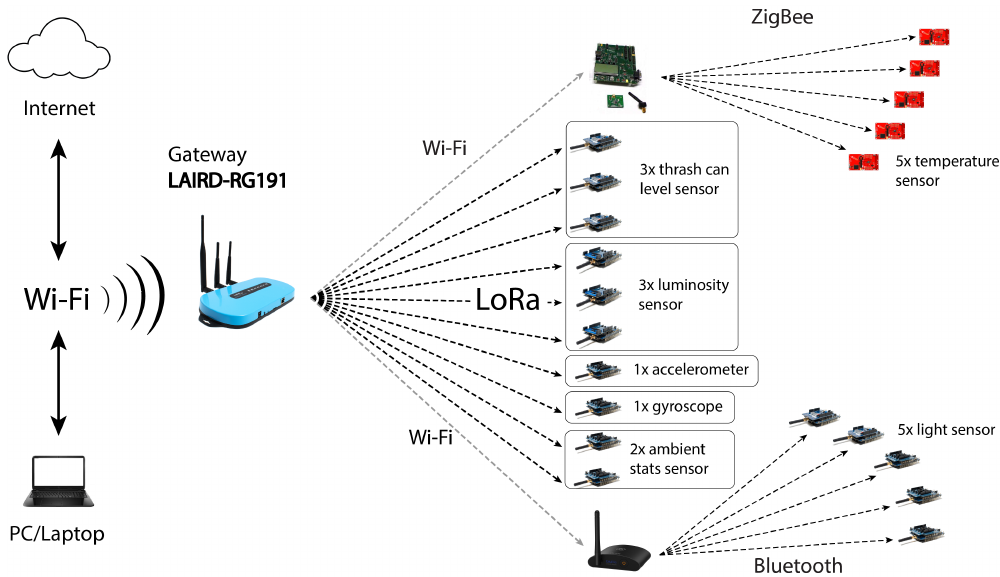
Figure 3. Network sensors under each technology.